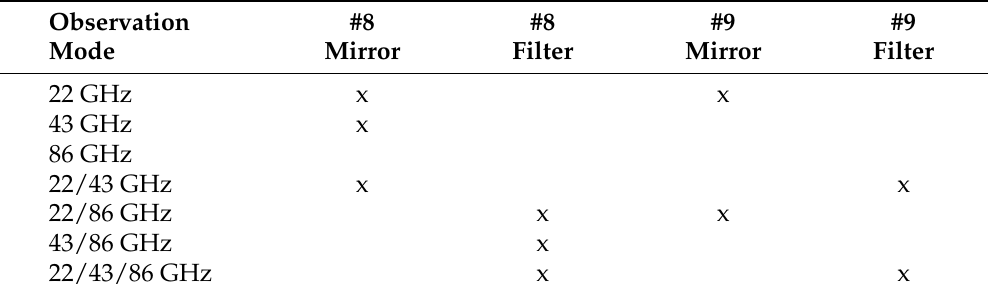
Table 1. Relation between combination of frequency separation filters/mirrors and observation mode.